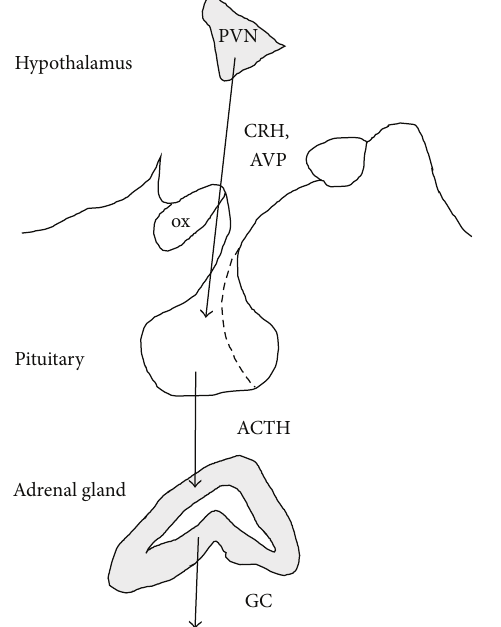
Figure 2: The stress axis: the activation of the hypothalamo- pituitary-adrenocortical axis is fundamental for adaptation. PVN: nucleus paraventricularis hypothalami, ox: optic chiasm, CRH: corticotropin-releasing hormone, AVP: arginine vasopressin, ACTH: adrenocorticotropin, and GC: glucocorticoids, in rodents